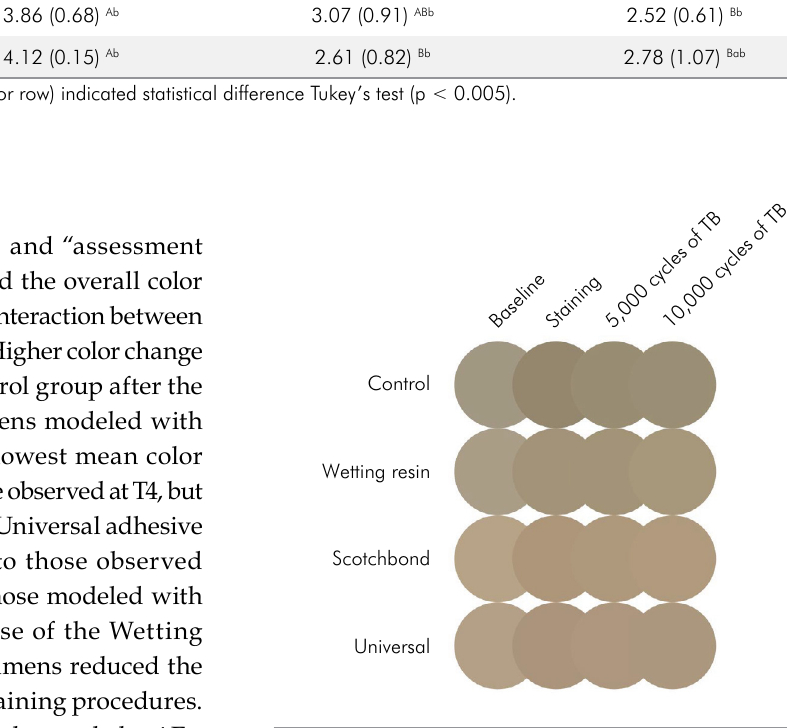
Figure 1. Behavior of color parameters according to treatment and assessment time. (A) parameter L* on the black-to-white axis, (B) parameter a* chromatic coordinates on the red-to- green axis, and (C) parameter b* chromatic coordinates on the yellow-to-blue